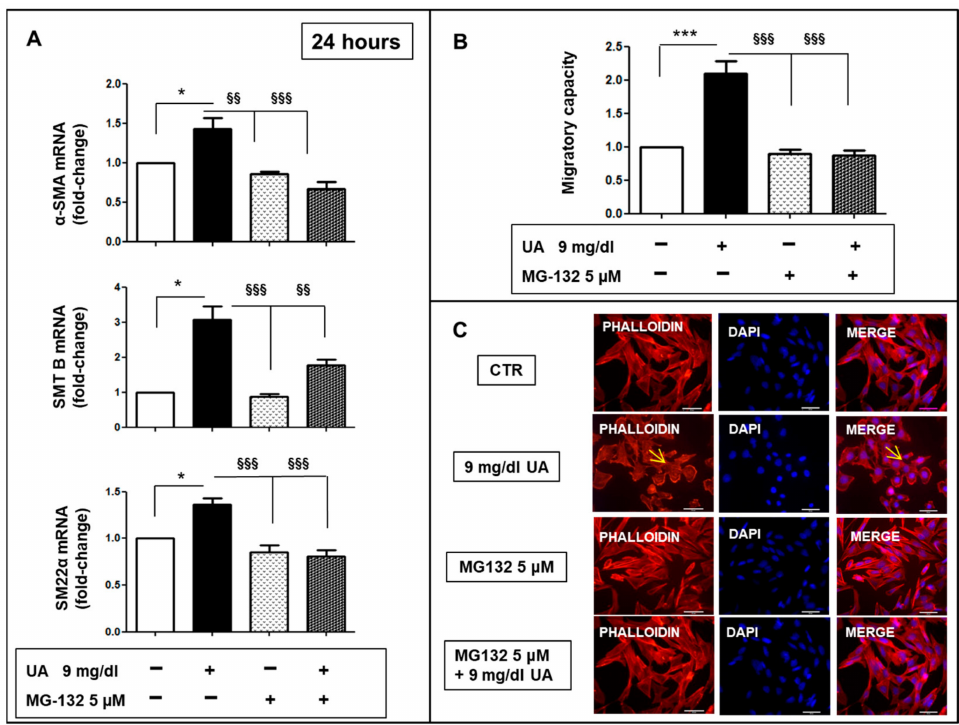
Figure 7. Role of ubiquitin–proteasome system in MOVAS phenotypic modification. ( A ) 5 µ M MG 132 pre-treatment inhibited the UA mediated overexpression of α -SMA, SMT B and SM22 α mRNAs, evaluated by rt-PCR, as well as ( B ) the migratory capacity. ( C ) AlexaFluor 594-Phalloidin staining showed that only in UA treated cells, F-actin has a cortical distribution, as pointed by yellow arrows (magnification × 400, scale bar = 50 µ m). Results represent means ± SEM obtained from three/four independent experiments and are expressed as fold change to CTR. * p < 0.05 and *** p < 0.0001 vs. CTR; §§ p < 0.01, §§§ p < 0.0001 vs. UA treated cells. UA = Uric Acid; α -SMA = α -Smooth Muscle Actin; SMT B = Smoothelin B; SM22 α = Smooth Muscle 22 α ; CTR = Control; DAPI = 4 (cid:48) ,6-diamidino-